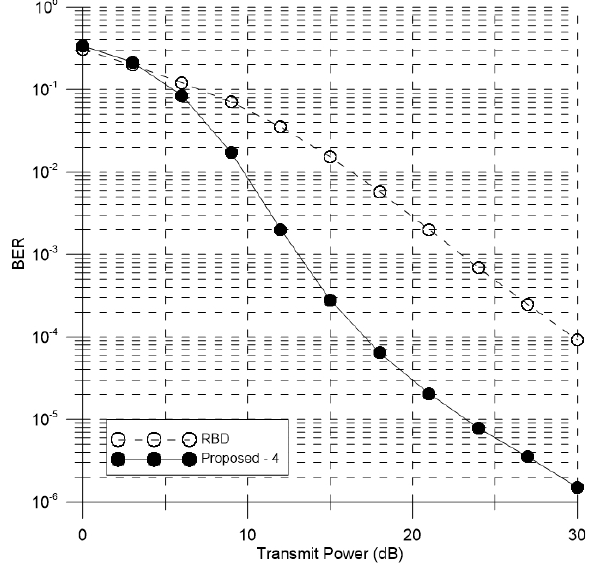
Figure 4. Bit error rate (BER) performance comparison between the RBD and the proposed scheme with N T = N R =